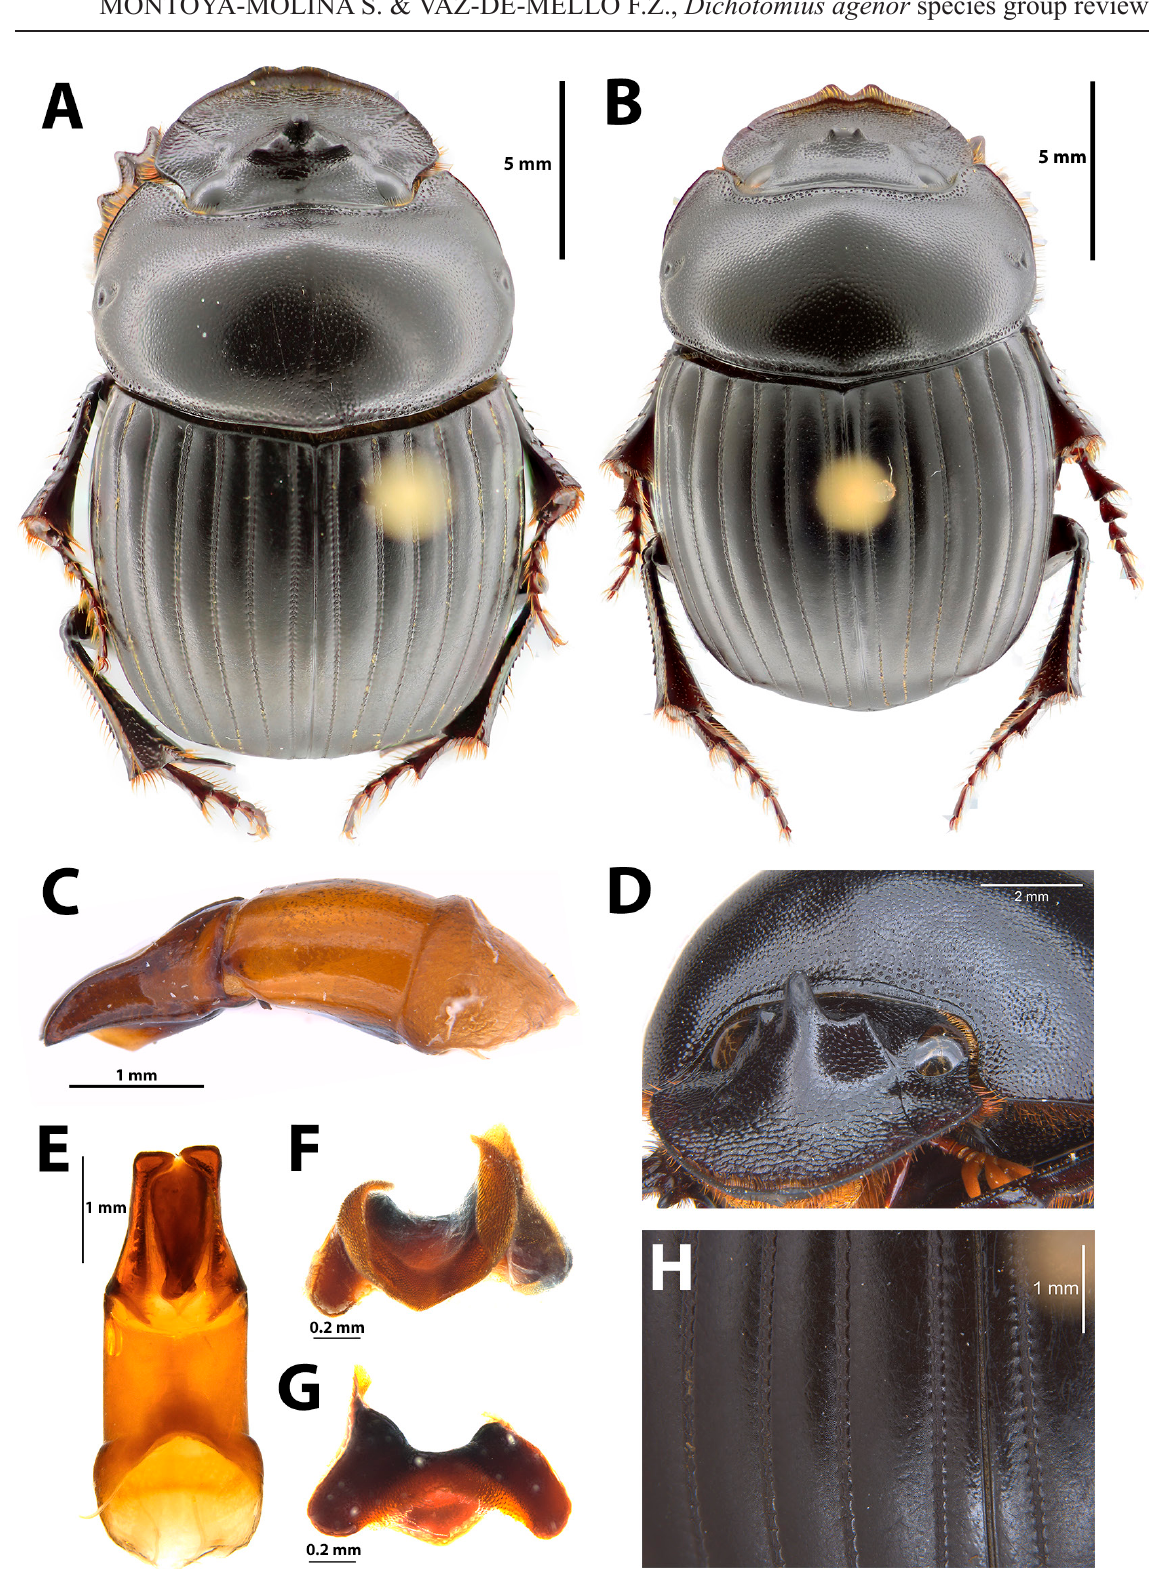
Fig. 6. Dichotomius centralis (Harold, 1869). A–B . Dorsal habitus. A . ♂. B . ♀. C . Lateral view of the aedeagus. D . Anterior view, head surface rugose, pronotal anterior surface showing subrugose punctation. E . Ventral view of the aedeagus. F–G . Lamella copulatrix. H . Elytral striae with crenulate